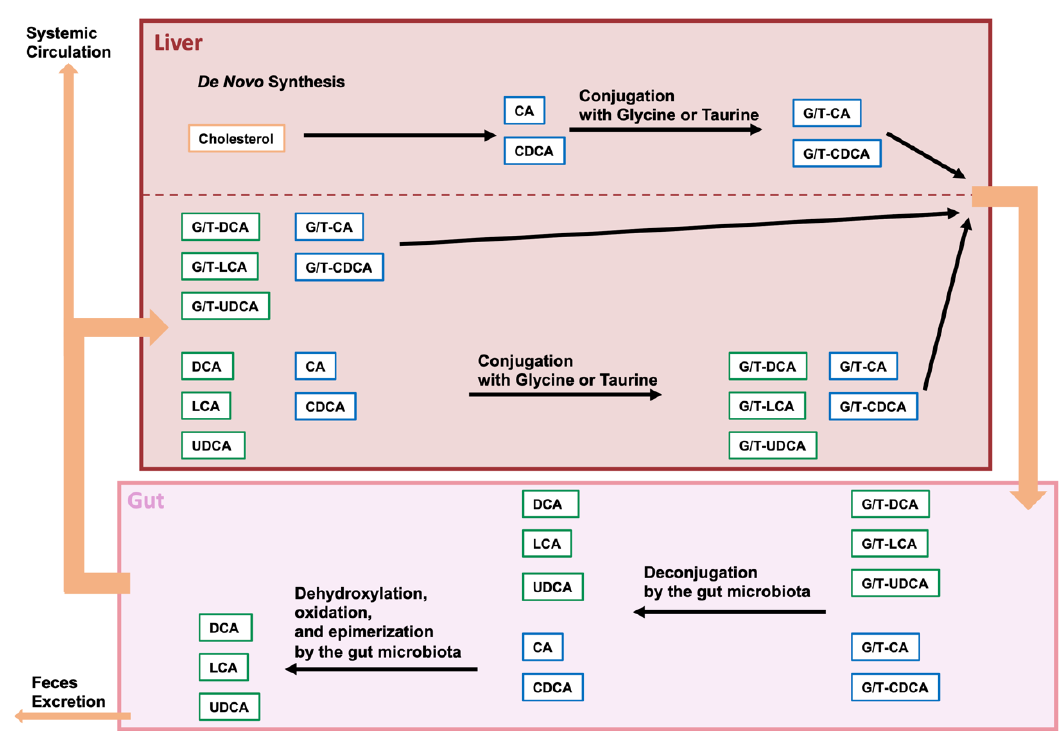
Figure 1. Modification of bile acids by the gut microbiome. Cholesterol is converted in the liver to cholic acid (CA) or chenodeoxycholic acid (CDCA), and these bile acids are then con-jugated with glycine or taurine (G/T). Conjugated CA and CDCA are transferred to the gallbladder and secreted from the gallbladder into the intestine upon food intake. Conjugated BA is deconjugated by intestinal bacterial bile salt hydrolases (BSHs), and CA and CDCA are further dehydrogenated to deoxycholic acid (DCA) and lithocholic acid (LCA), respectively. CDCA is also dehydrogenated and epimerized by intestinal bacteria and converted to ursodeoxycholic acid (UDCA). Approximately 95% of the BAs in the gut are absorbed and transferred to the liver, while the remaining BAs are excreted in the feces. Some of the BAs reabsorbed from the gut are effluxed into the systemic circulation.